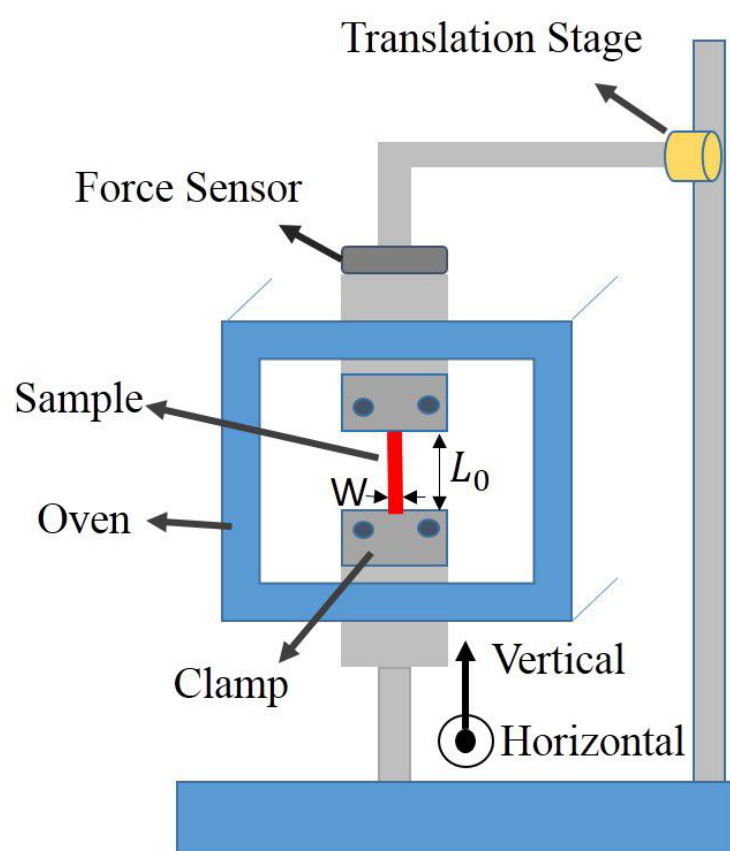
Figure 5. Oven chamber that contains the fiber sample and an external force sensor in series with the upper clamp used for thermo-mechanical and photomechanical experiments. The pump laser beam travels into the page and illuminates the whole face of the fiber.